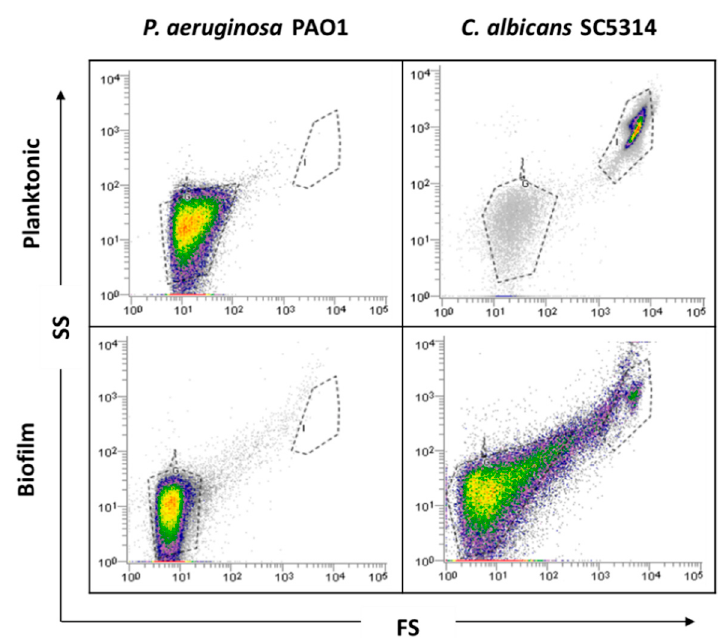
Figure 1. Representative dot plots obtained for planktonic cells and single biofilms of P. aeruginosa PAO1 and C. albicans SC5314 by flow cytometry (FCM).